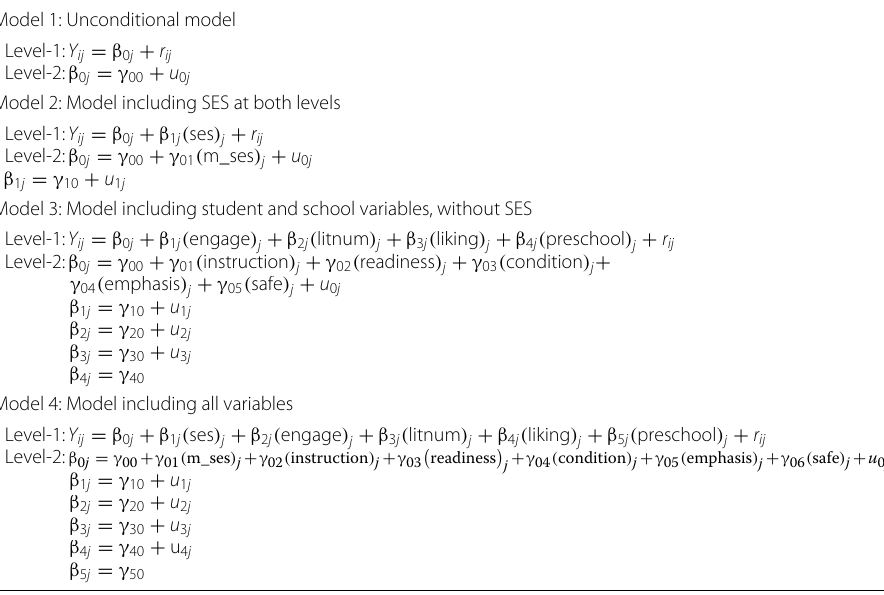
Table 2 Hierarchical linear models used to answer research questions Model 1: Unconditional